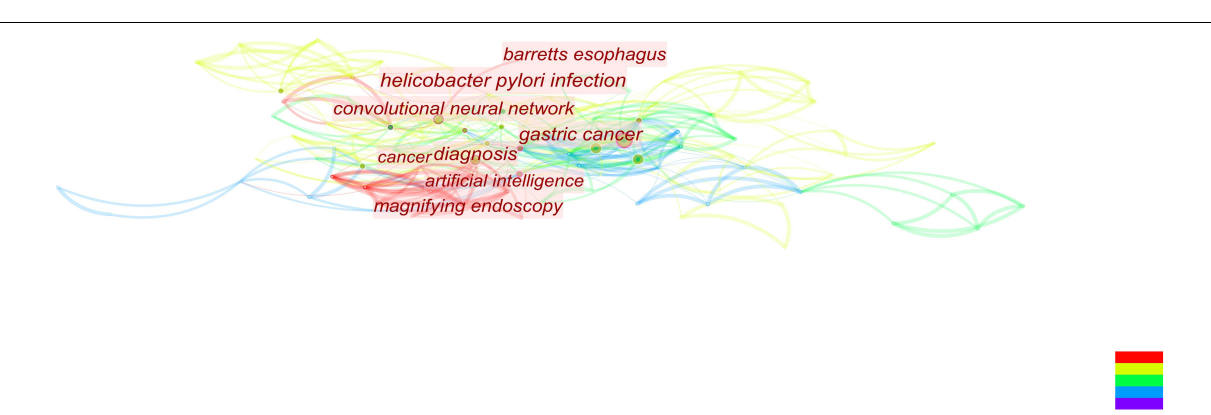
these countries (0.43 in Japan and 0.35 in Korea),